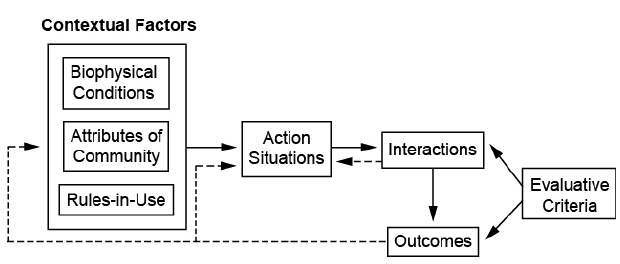
Fig. 1. Institutional analysis and development